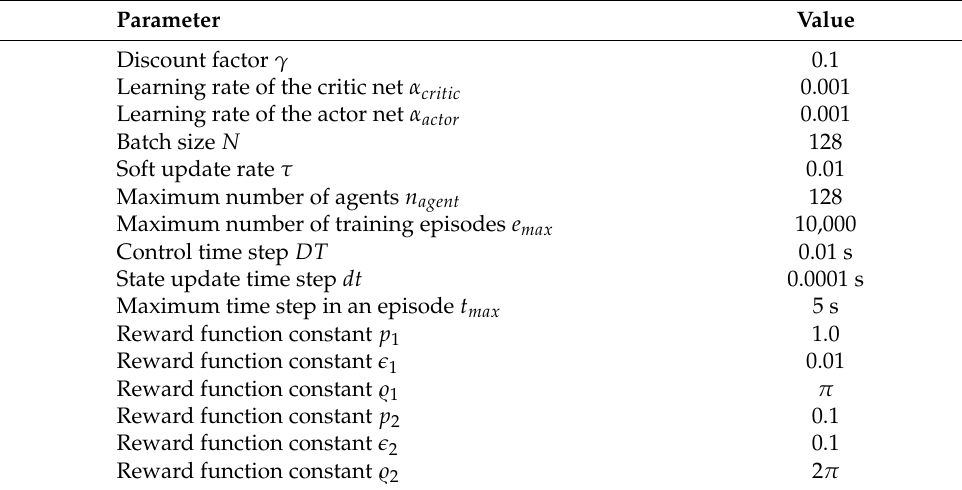
Table 3. Training hyperparameters.